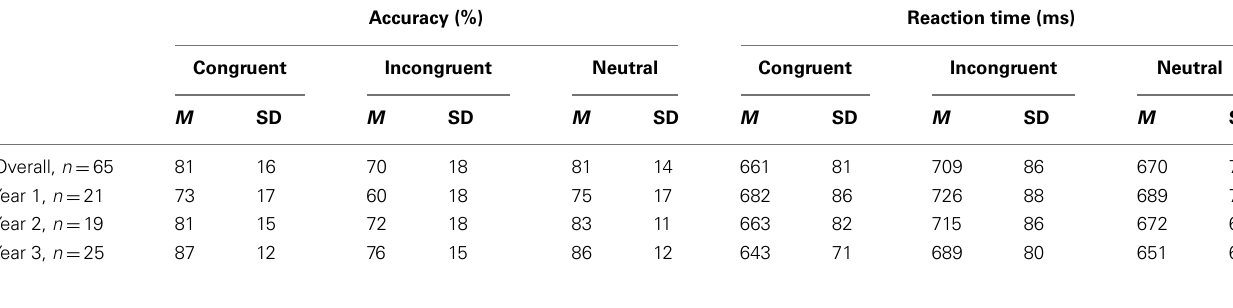
Table 2 | Behavioral NSP data: overall and year group means (accuracy) and medians